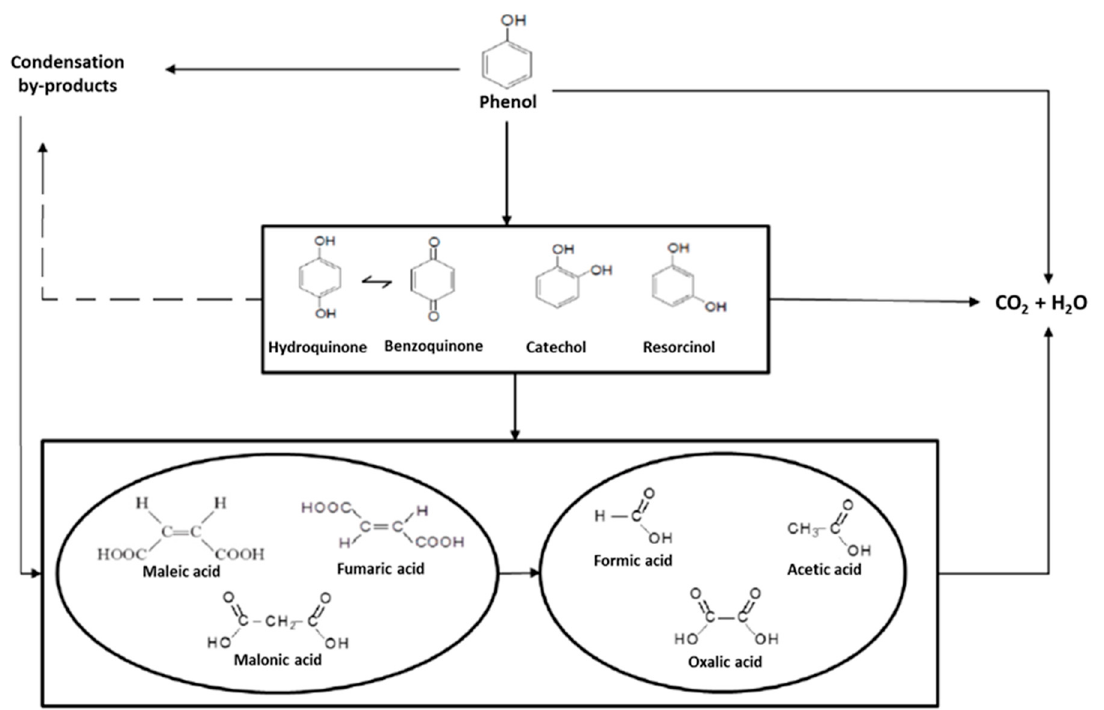
Figure 5. Proposed reaction pathway for the degradation of phenol by WPO-O 2 .